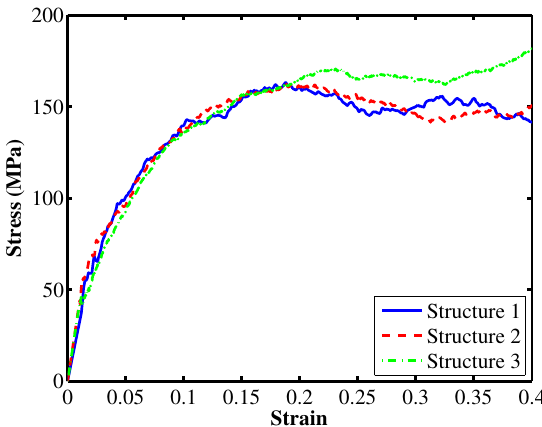
Figure 3. Stress-strain responses corresponding to three different initial PE systems at temperature of 250